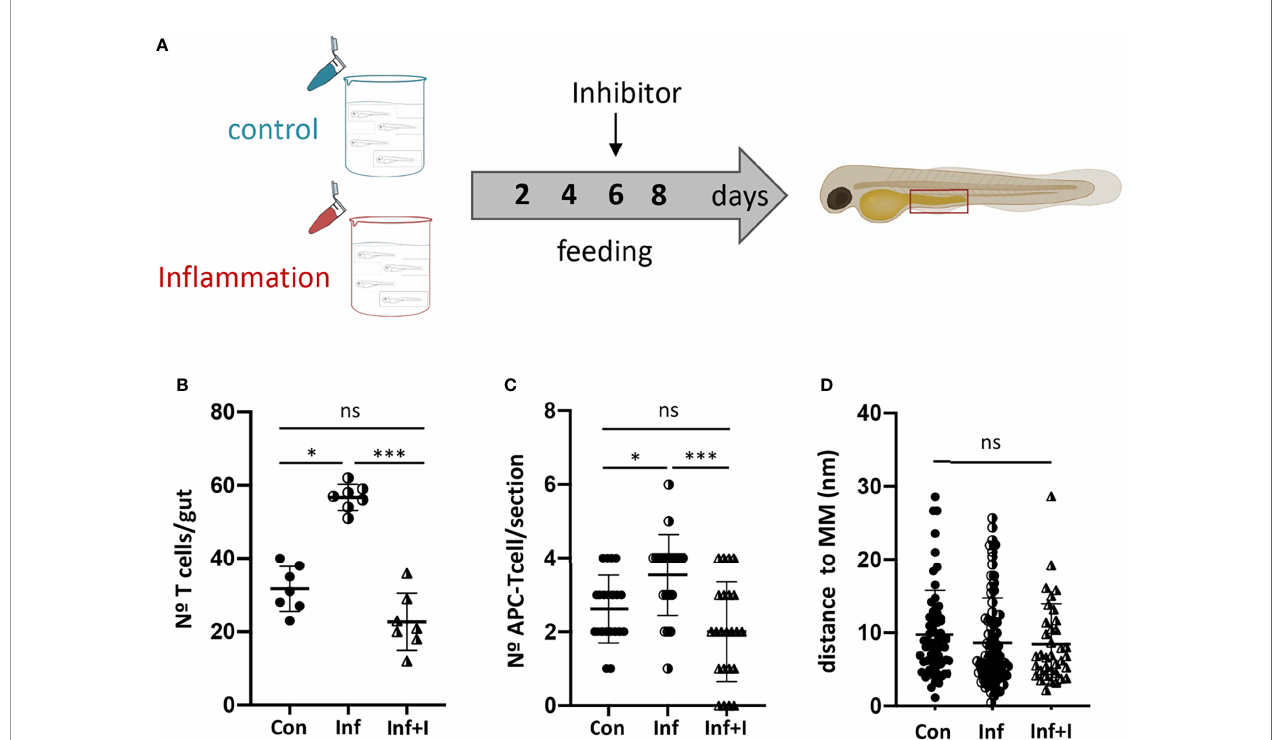
FIGURE 5 | Ccr9-Ccl25 control APC-T cell interaction in the posterior intestine. (A) Experimental strategy used to inhibit Ccr9 receptor by treating fi sh with the speci fi c inhibitor CCX282-B. (B) Quanti fi cation of the number of GFP+ T cells in the posterior intestine of Tg(lck:GFP) fi sh in control, in fl ammatory condition and treated condition. (C) Quanti fi cation of the number of APC-T cell couples per cryostat section in control condition, in fl ammatory and treated condition. (D) Quanti fi cation of the distance of each couple to the muscularis mucosa per section in control, in fl ammatory and treated condition. Statistical analysis was performed with the Kruskal Wallis test. n.s., non- signi fi cant, *p < 0.05, ***p < 0.001. All assays were performed at least three independent